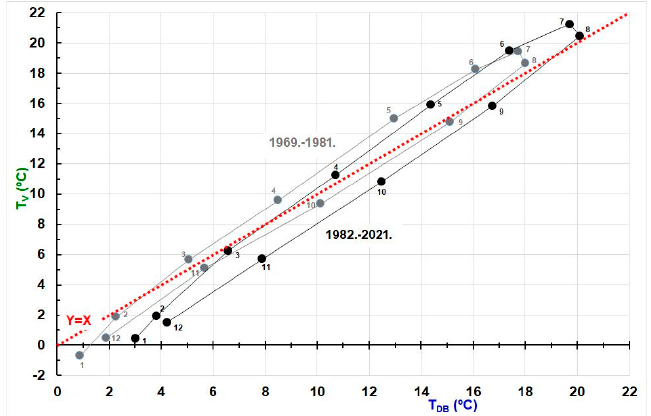
Figure 10. Graphic representation of the relationship between the average monthly water tempera- tures of the Drava at the Botovo station (abscissa axis), T DB , and the average daily air temperatures at Varaždin (ordinate axis), T V , during the following two subperiods: (1) 1969–1981 (Gray color) and (2) 1982–2021 (black).